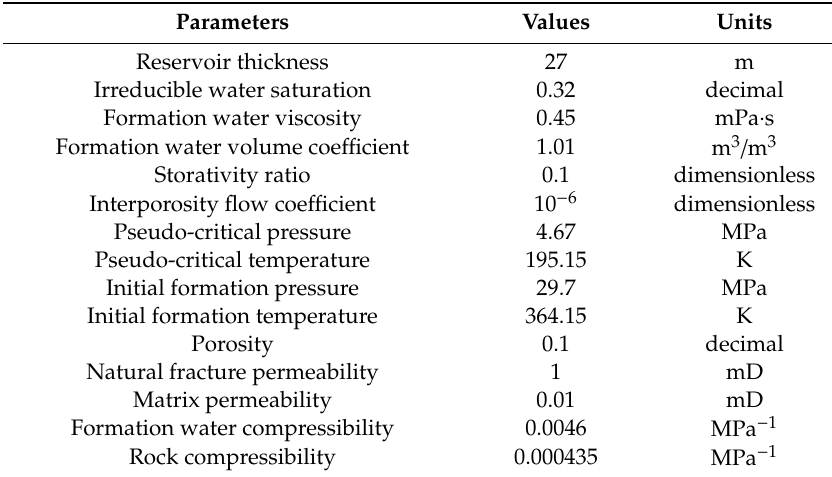
Table 1. Data parameters of gas reservoir